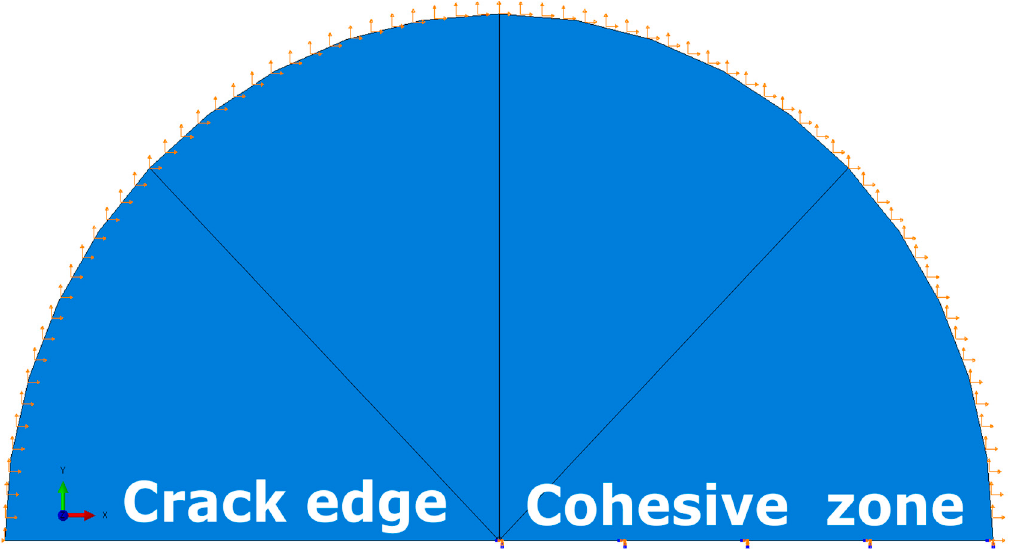
Figure 2. Boundary Figure 2. Boundary conditions.